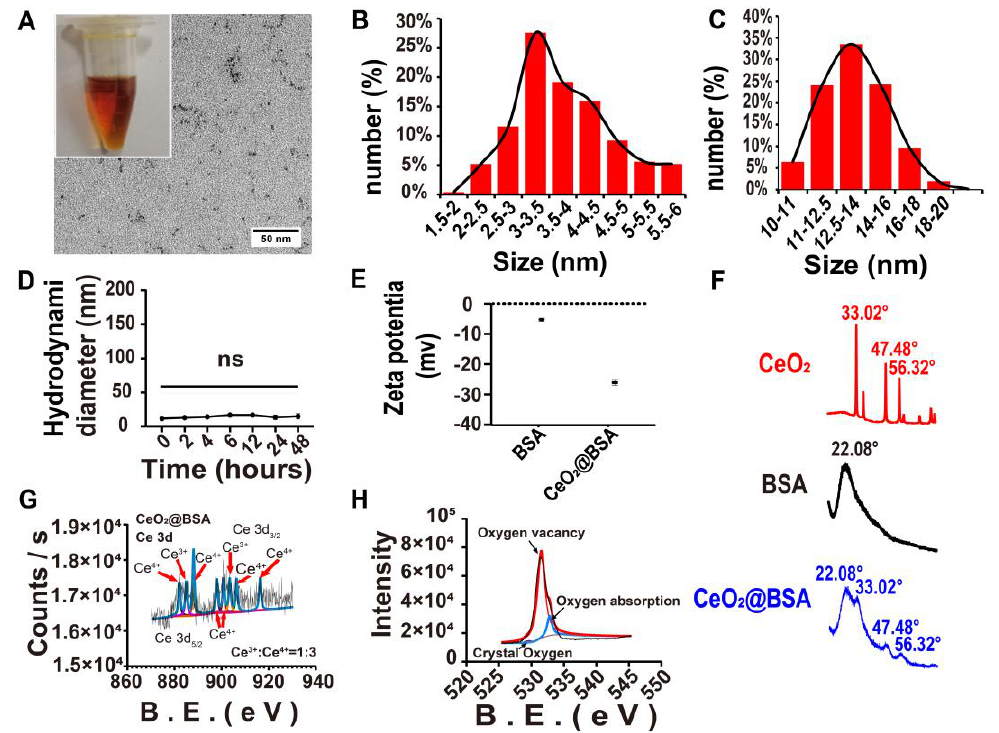
Figure 2. CeO 2 @BSA NP characterization. ( A ) Appearance and TEM images (Scale bar = 50 nm) of NPs. ( B ) Size distribution of nanoparticles as shown in ( A ). ( C ) Diameter distribution of nanoparti- cles measured via DLS. ( D ) Particle size at different points in 48 h measured by DLS. ( E ) Zeta po- tential of BSA and NPs. ( F ) XRD of CeO 2 , BSA, and NPs. ( G ) XPS of the spectrum of the Ce3d. ( H ) XPS of the spectrum of the O1s. TEM: transmission electron microscopy, DLS: dynamic light scat- tering, XRD: X − ray diffraction, XPS: X − ray photoelectron spectroscopy. Data are expressed as mean ± SEM of three independent